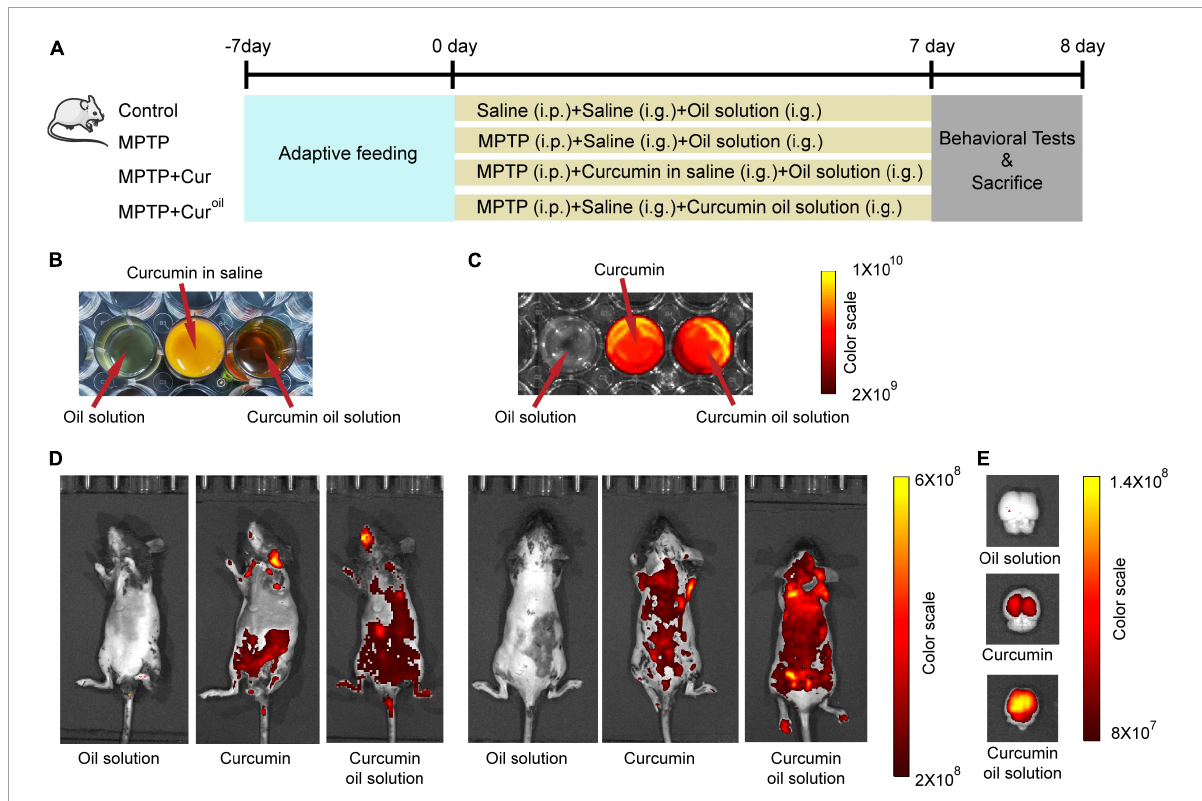
FIGURE1 The curcumin oil solution showed higher bioavailability in mice. (A) The schedule of the experiment assignment. (B) The appearance of the oil solution without curcumin, curcumin in saline and prepared curcumin oil solution. (C) The fluorescence images of oil solution without curcumin, curcumin and curcumin oil solution. (D) The in vivo imaging of mice 1 h after the administration with oil solution without curcumin, curcumin in saline, and curcumin oil solution. (E) The fluorescence images of isolated brain tissues from mice 1 h after the administration with oil solution without curcumin, curcumin in saline, and curcumin oil solution. In C-E, the excitation and emission wavelengths were 430 and 509 nm,